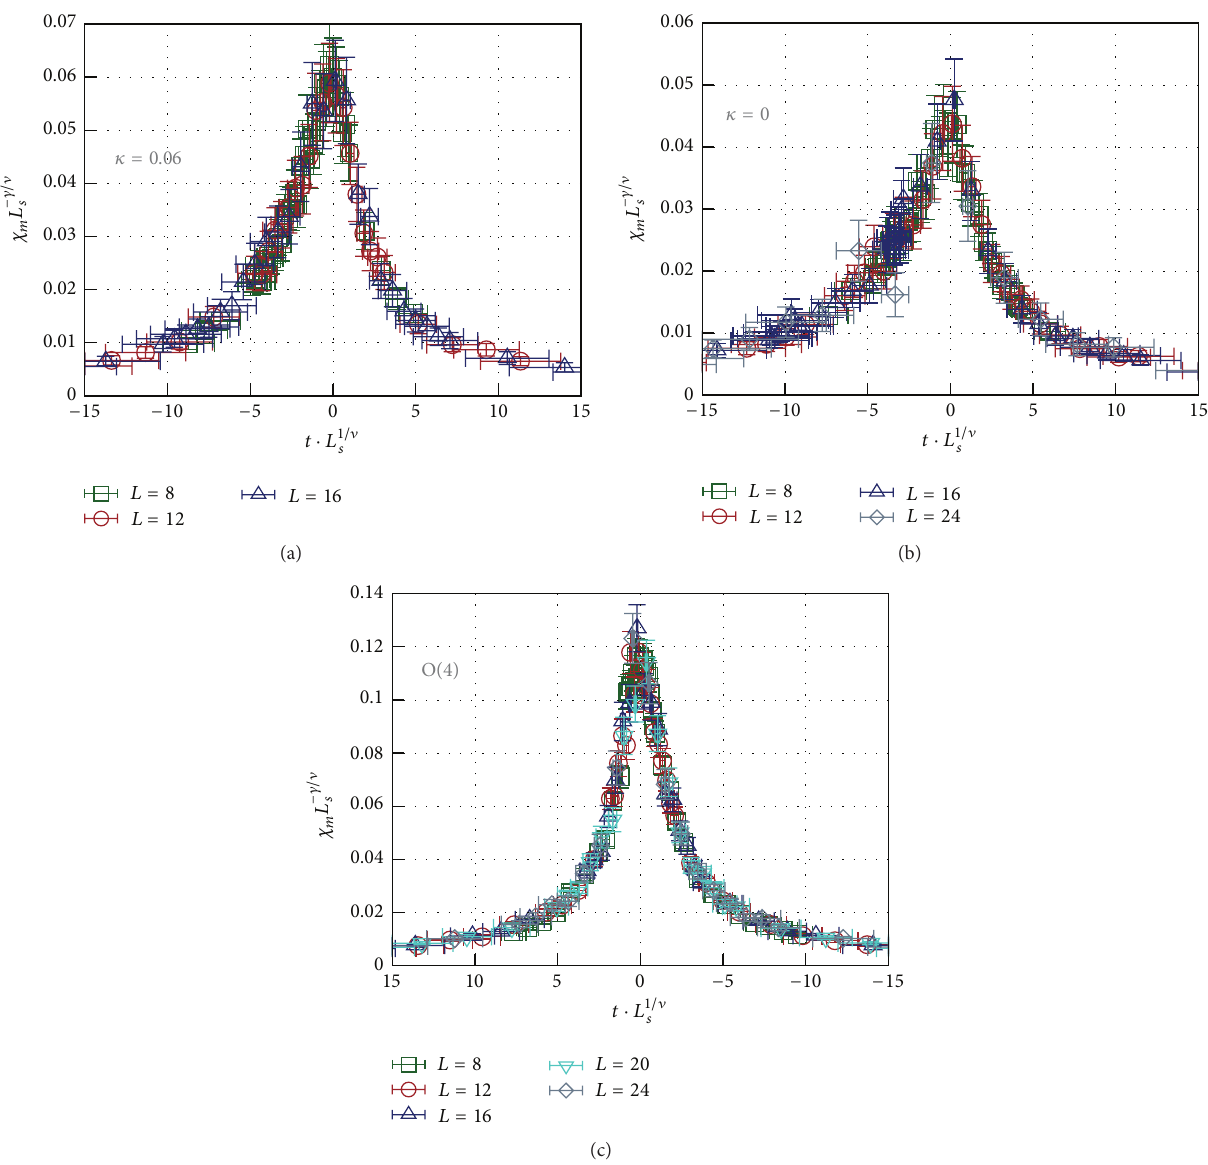
Figure 9: Scaling behaviour of susceptibility at 𝜅 = 0.06 (a), 𝜅 = 0.00 (b), and the O(4) model (c) for various volumes. Table 2: Results of a correlated fit to the susceptibility according to (35) where the last column indicates the fit interval. The parameter 𝑇 stands either for 𝑦 in the Higgs-Yukawa model or for 𝜅 in the O(4) model. Since no volume-dependent shift can be observed in the O(4) model for 𝜒 𝑚 , the parameters 𝐶 and 𝑏 have not been fitted here. All quoted errors are statistical only. 𝑇 (𝐿=∞) 𝜈 𝛾 𝐶 𝑏 Fit interval 𝑐 𝜅 = 0.06 𝜅 = 0.00